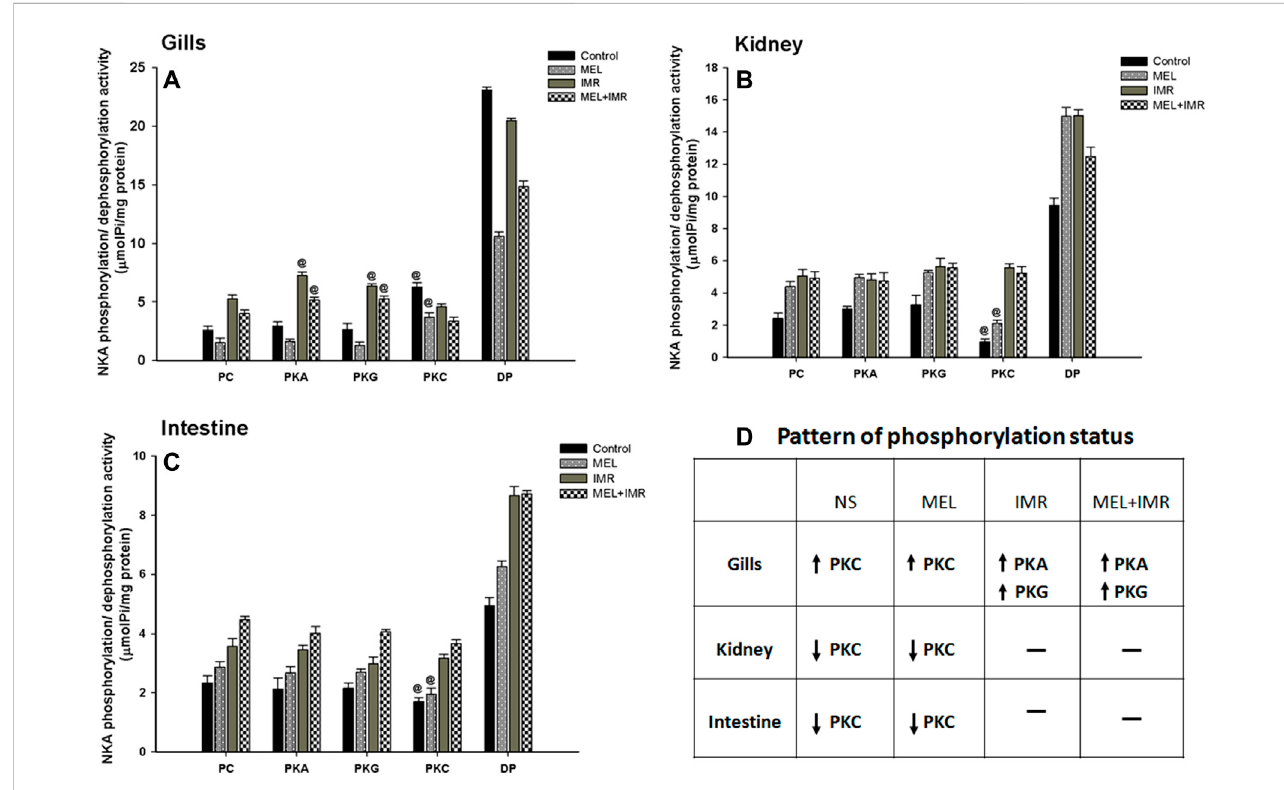
FIGURE 6 PhosphorylationanddephosphorylationstatusofNKAingillepithelia (A) ,posteriorkidney (B) andanteriorintestine (C) aftermelatonin(Mel)treatmentin non-stressed or immersion-stressed (IMR) fi sh. PC, Phosphorylated control; PKA, Protein kinase A; PKG, Protein kinase G; PKC, Protein kinase C; DP, dephosphorylated control using alkaline phosphatase. Each column represents mean ± SEM and the signi fi cance were accepted when p < .05. “ @ ” denotes signi fi cance between non-stressed and stressed fi sh. “ # ” denotes signi fi cance between non-stressed control (0) and immersion stressed (IMR) + melatonin (MEL) treated fi